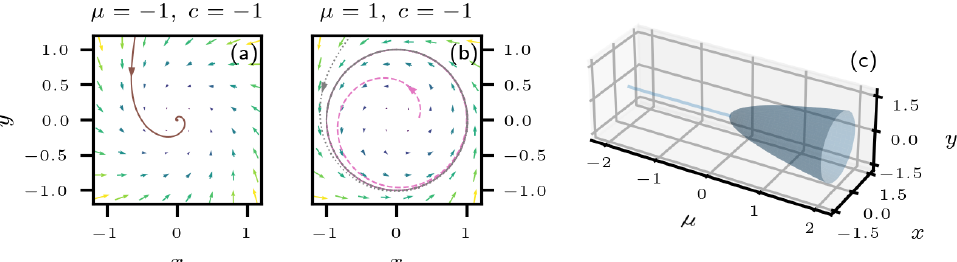
Figure 4. Supercritical Hopf bifurcation. (a) Vector field ˙ z ( z ) of Eq. (3) for the parameter values µ = − 1 and c = − 1; z = x + ıy . In this case, the origin constitutes the only stable fixed point, and all trajectories will spiral into this point, as illustrated by the single brown trajectory. (b) Vector field ˙ z ( z ) and three trajectories for µ = 1. In this case, the origin is an unstable fixed point, while the limit cycle with radius ρ 1 / 2 ∗ = 1 constitutes the only stable solution. Trajectories that start inside this limit cycle, with ρ ( t 0 ) < ρ ∗ , tend to it by spiraling out – as illustrated by the magenta trajectory – while trajectories that start outside the limit cycle, with ρ ( t 0 ) > ρ ∗ , approach it by spiraling inward, as illustrated by the gray trajectory. (c) Dependence of the stable solution of Eq. (3) on the parameter µ , for c = − 1. For µ ≤ 0, the single stable solution is the fixed point located at the origin, ρ ≡ 0. For µ > 0, the stable solution is the limit cycle given by ρ = µ